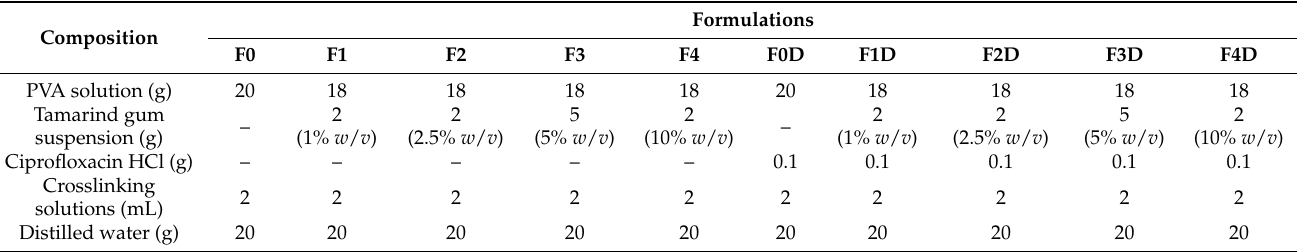
Table 6. Formulation of the PVA-TG